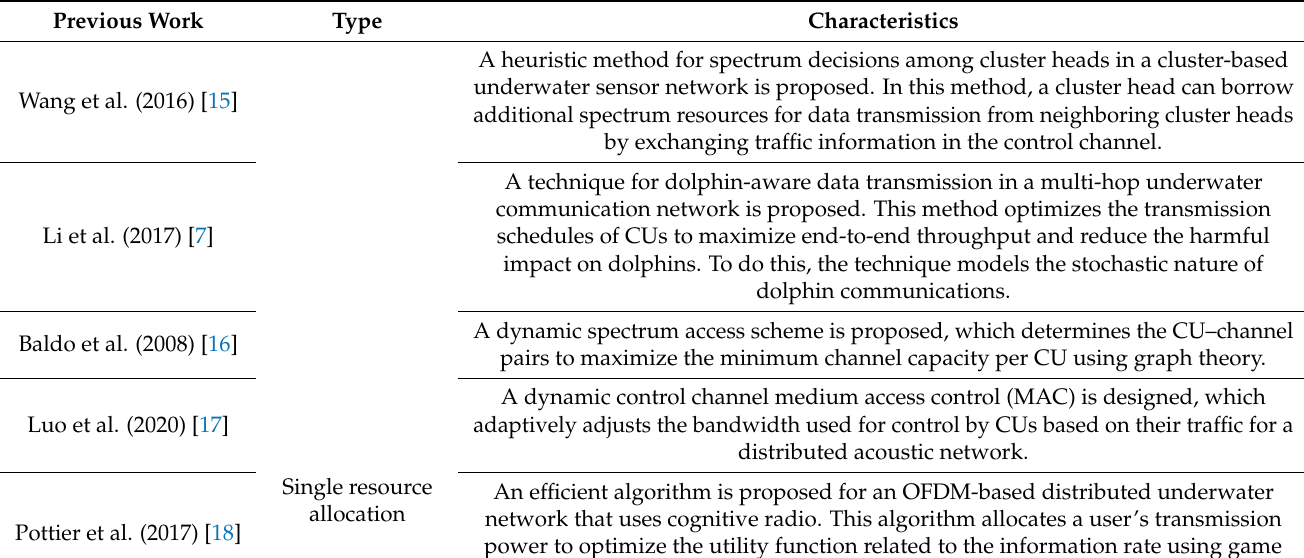
Table 1. Summary of previous works on